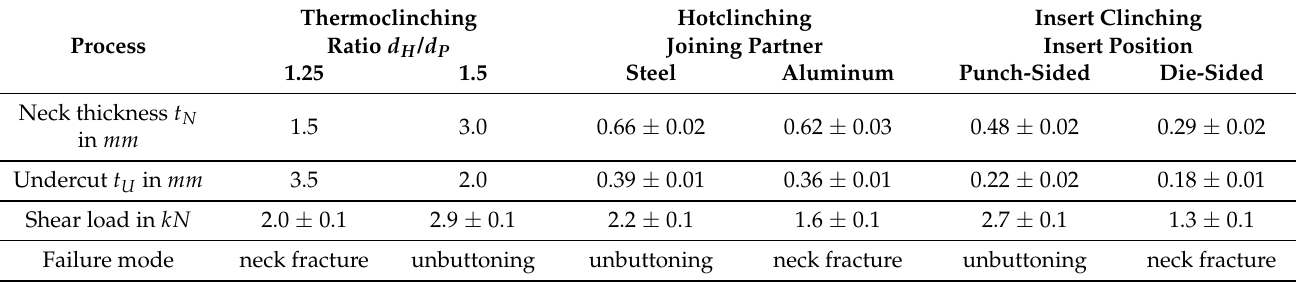
Figure 15. Insert Clinching: Results of single-lap shear tests under quasi-static load for clinch inserts in punch-sided and die-sided orientation: ( a ) load-displacement curves, ( b ) characteristic failure behaviour. Table 2. Characteristics of the investigated